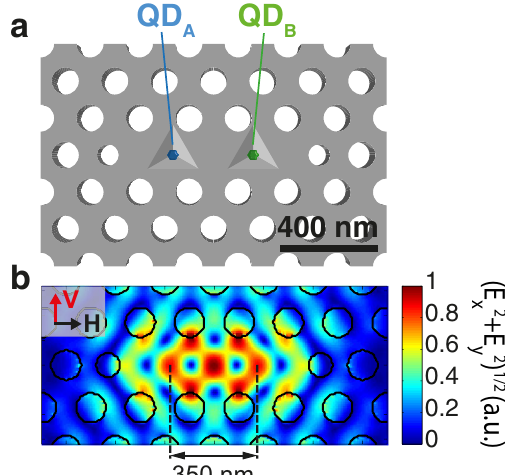
Figure 1. Deterministic integration of two pyramidal QDs with a modified L 3 PhC membrane cavity. ( a ) Schematic illustration. ( b ) Simulated near field intensity pattern of the fundamental optical mode. The distance between the two QDs (350 nm) is equal to that of the field lobes as indicated.